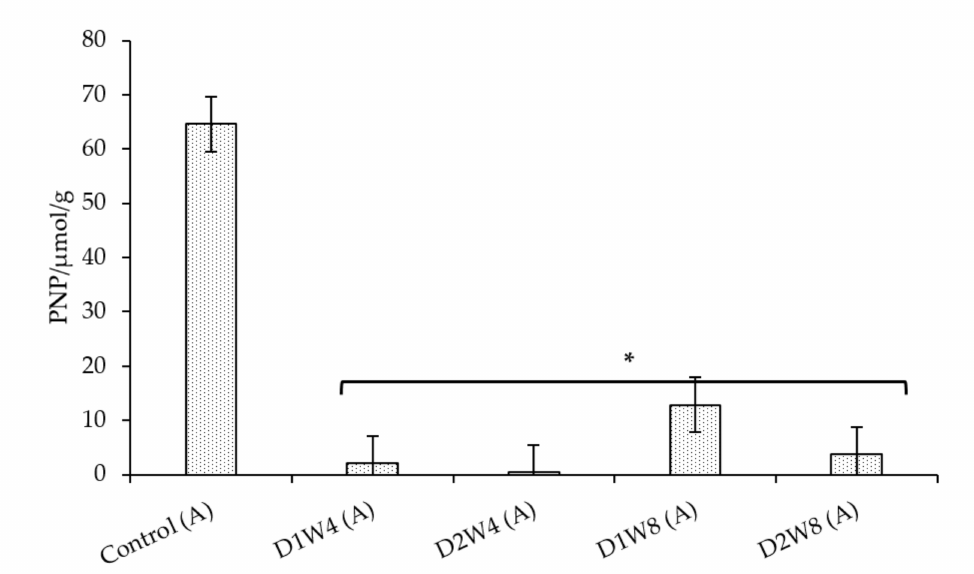
Figure 4. Glucosidase enzyme activity (GlA) of Arenosol. The codes mean the following treatments: Control (A): Control Arenosol. D1W4 (A): Dose 1 week 4 (Arenosol). D2W4 (A): Dose 2 week 4 (Arenosol). D1W8 (A): Dose 1 week 8 (Arenosol). D2W8 (A): Dose 2 week 8 (Arenosol). * indicates significant difference at p < 0.05 (calculated by Duncan-test) between control and compost tea treated soils.